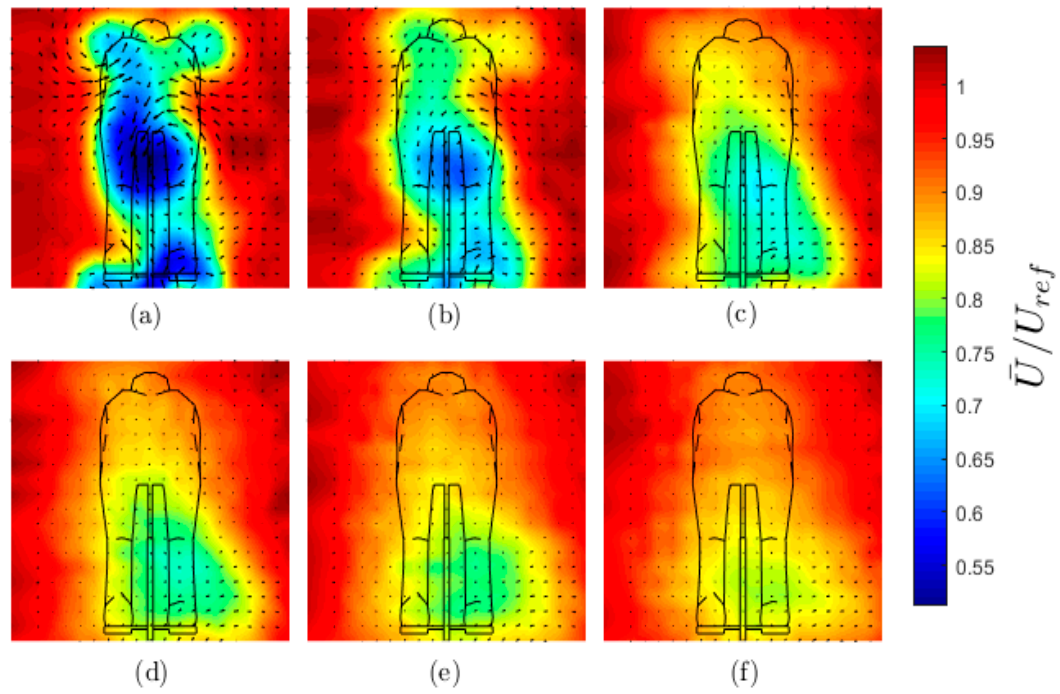
Figure 2. The time-average velocity color contour maps of the streamwise velocity ( u ) overlaid with projected velocity vectors in Y - Z planes behind the Monash cycling mannequin with the legs in the low drag (0°) position. Downstream locations are: ( a ) 0.63 m; ( b ) 1.26 m; ( c ) 2.52 m; ( d ) 3.78 m; ( e ) 5.04 m; and ( f ) 6.93 m.